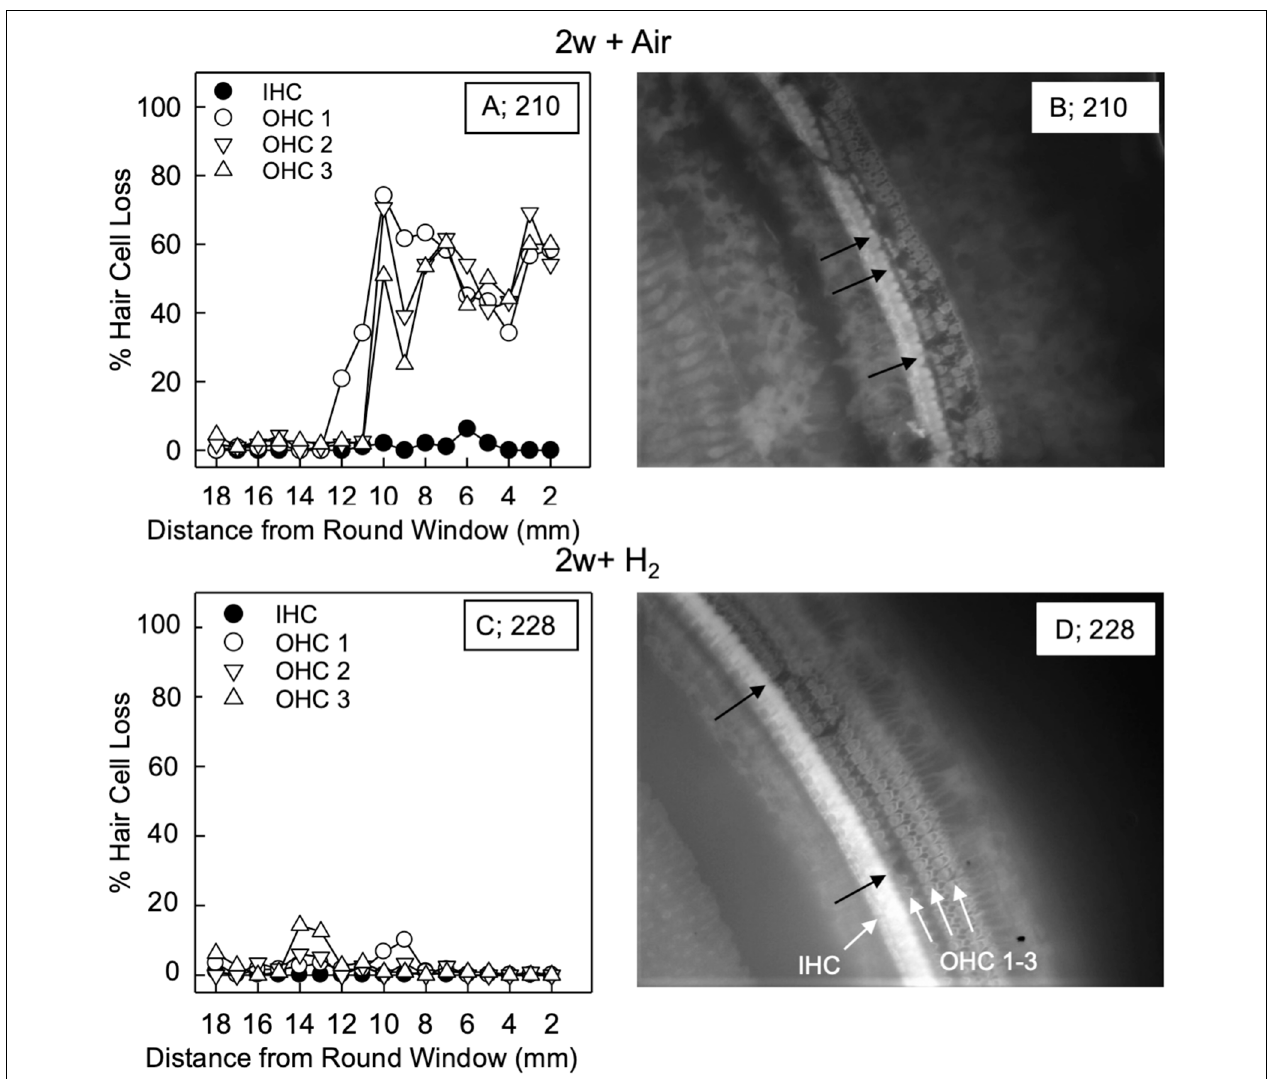
FIGURE 3 | Representative cochleogram from group 2w + Air (A) and group 2w + H 2 (C) . (B) Micrograph from the surface preparation of the same animal as (A) in the 10 mm area from the round window (RW). The black arrows indicate hair cell loss in all three rows of outer hair cells (OHCs). (D) Micrograph from the surface preparation of the same animal as (C) in the 10 mm area from the RW. The black arrows indicate hair cell loss in the first row of OHCs. The white arrows indicate inner hair cell (IHC) and the three rows of OHCs 1, 2 and